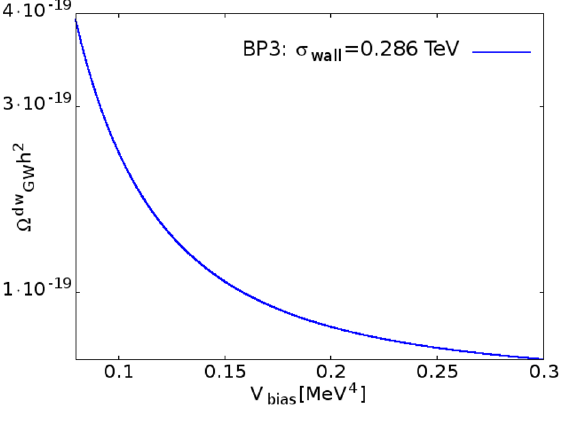
Figure 1. The variation of the GW intensity Ω dw V bias for BP